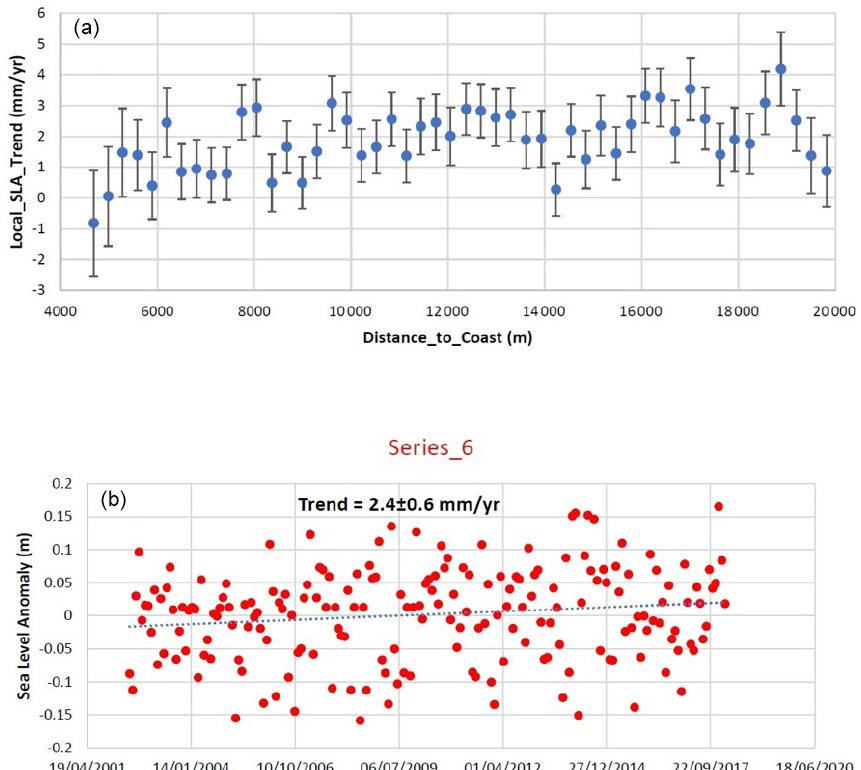
Figure 13. (a) shows the monthly local sea level anomaly trend with respect to distance to the coast. (b) shows the monthly time series of one point (Series_6) selected as an example, with indication of least square